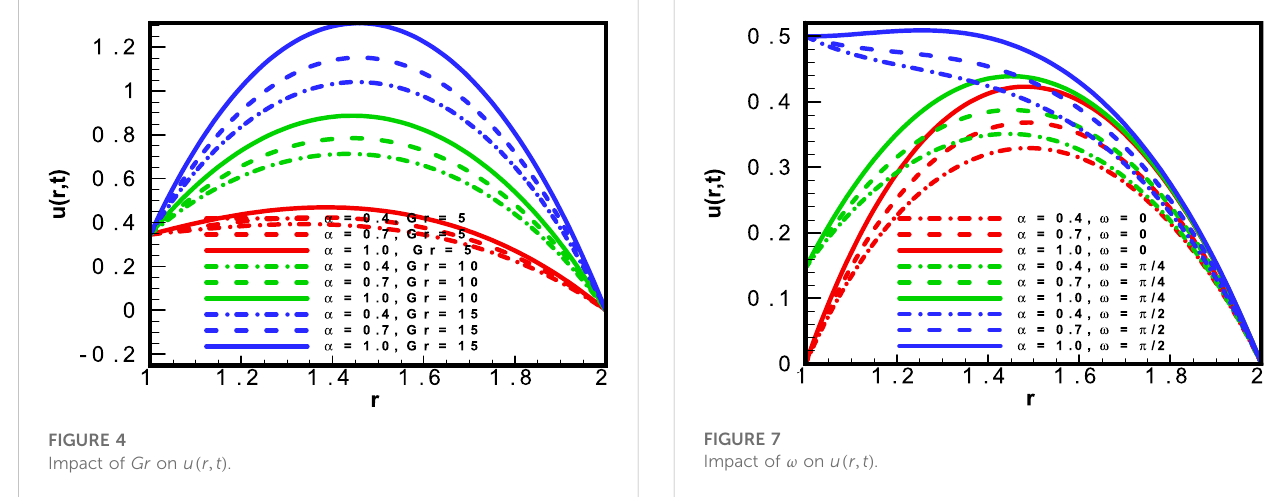
FIGURE 7 Impact of ω on u ( r , t )